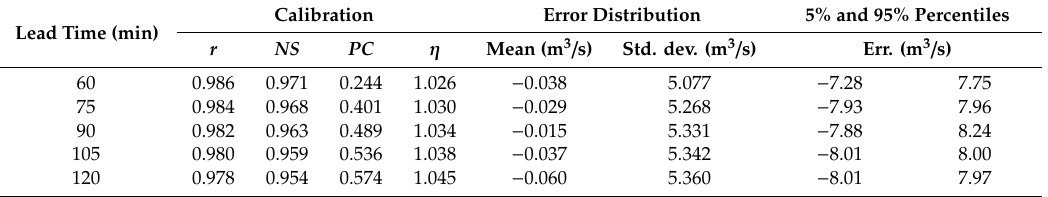
Table 2. Model-1 performance evaluation coefficients and forecasting error statistics (calibration data set).